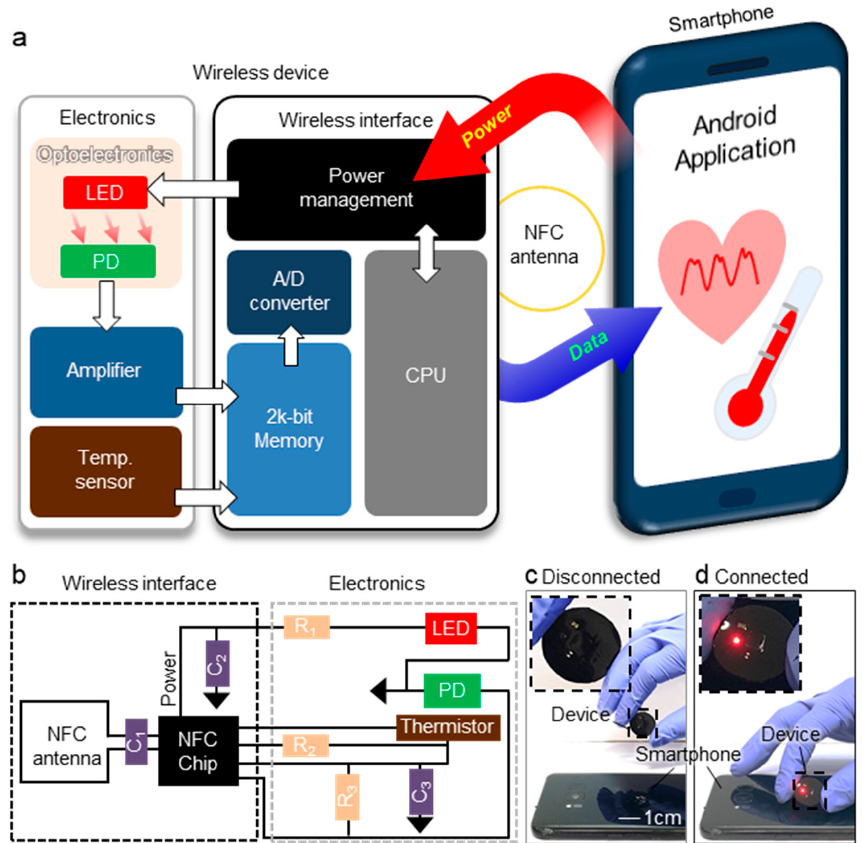
Figure 3. Operating system of wireless sensor. ( a ) Block diagram for operation of wireless sensor. ( b ) Circuit diagram of wireless sensor. Photograph images of device in state of ( c ) disconnected and ( d ) connected with smartphone.